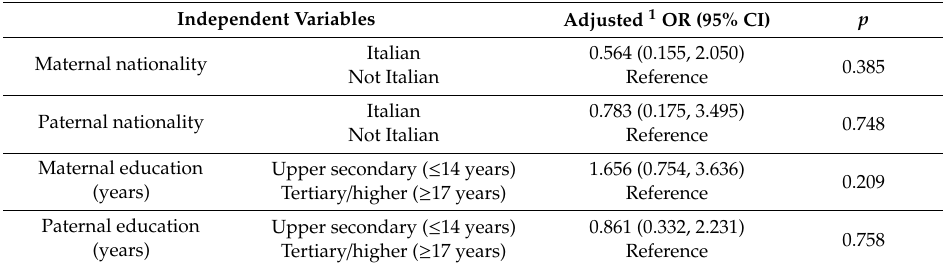
Table 3. Logistic regression analysis of parental nationality and educational level associated with no / partial smoking ban at home among the subgroup of monitored schoolchildren exposed to Environmental Tobacco Smoke